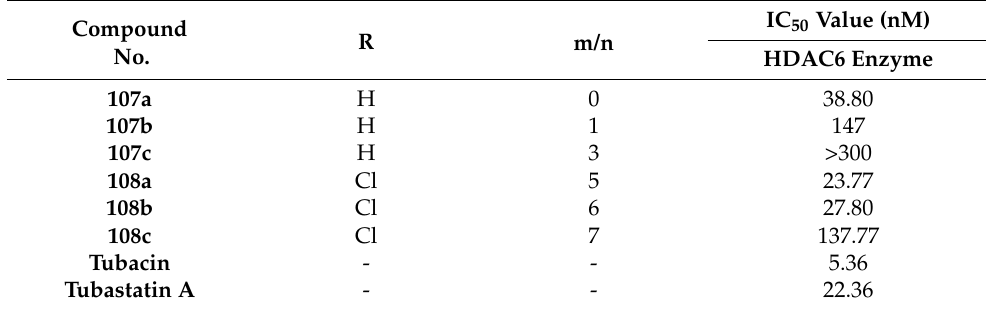
Figure 102. Structure of pyrrolo ‐ benzodiazepine ‐ dione derivatives [ 107 ( a – c ), 108 ( a – c )]. Table 91. In vitro cytotoxic activities of pyrrolo-benzodiazepine-dione hybrid compounds [ 107 ( a – Table 91. In vitro cytotoxic activities of pyrrolo ‐ benzodiazepine ‐ dione hybrid compounds [ 107 ( a – c ), 108 ( a – c )]. c ), 108 ( a – c )].